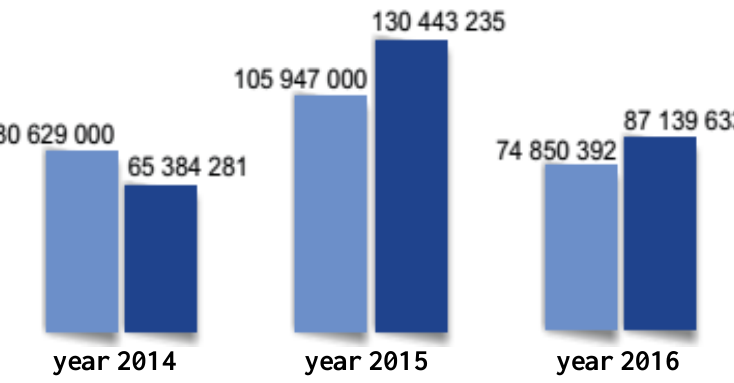
Fig. 3. Table on the auctions announced in 2014, in 2015, in 2016 (National Agency of State Property, n. d.).